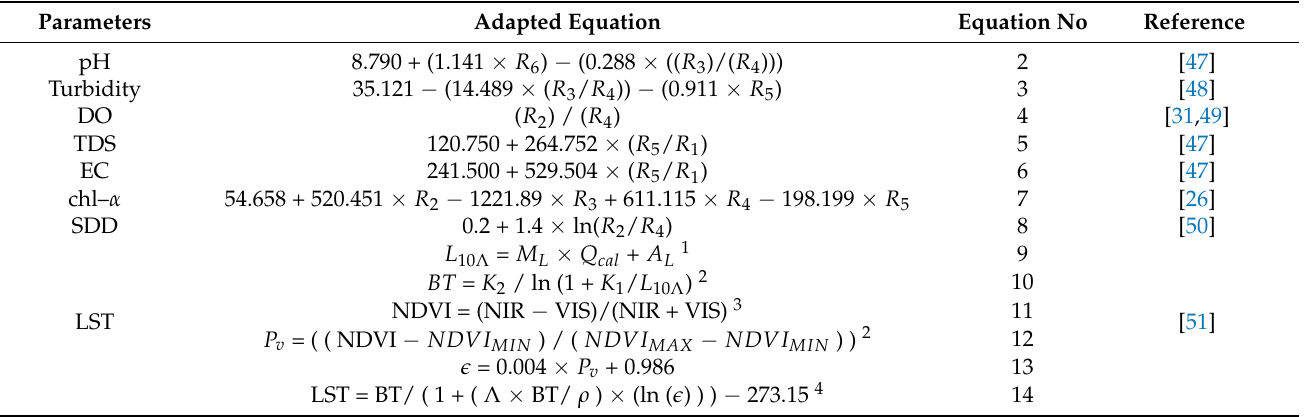
Table 2. Calculations performed to determine pH, Turbidity, DO, TDS, EC, Chl– α , SDD, and LST using Landsat 8